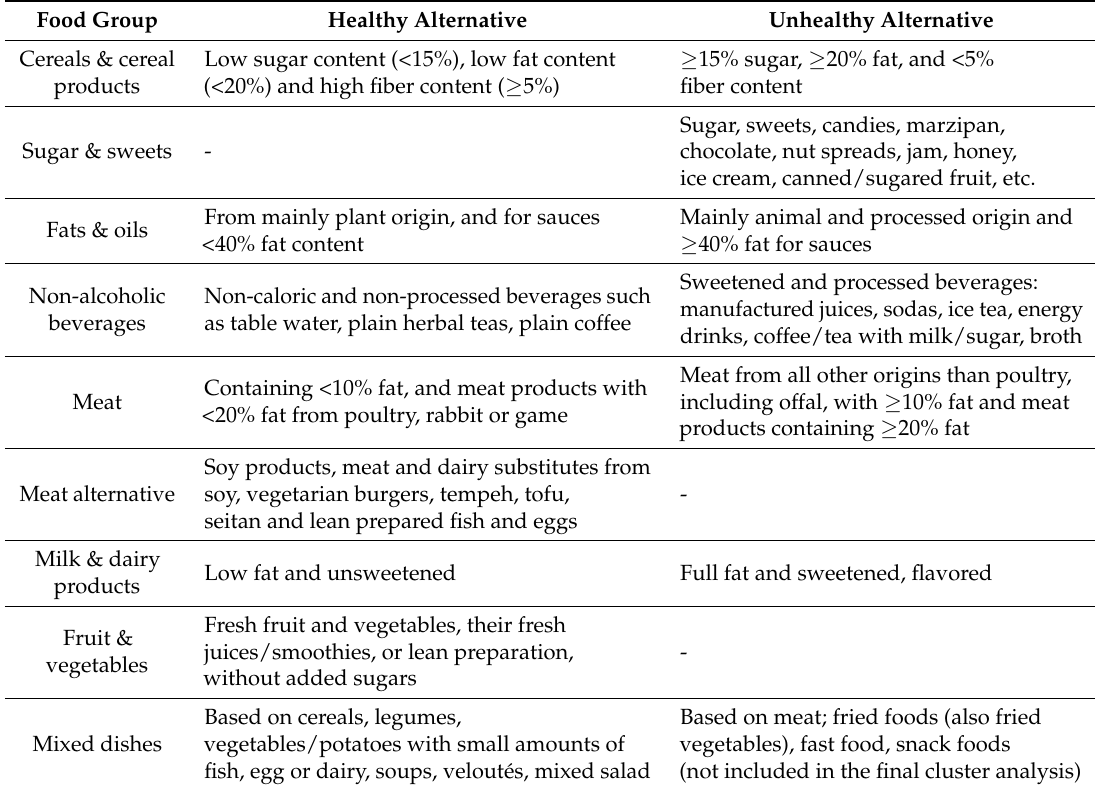
Table 1. Food groups and healthy/unhealthy dietary